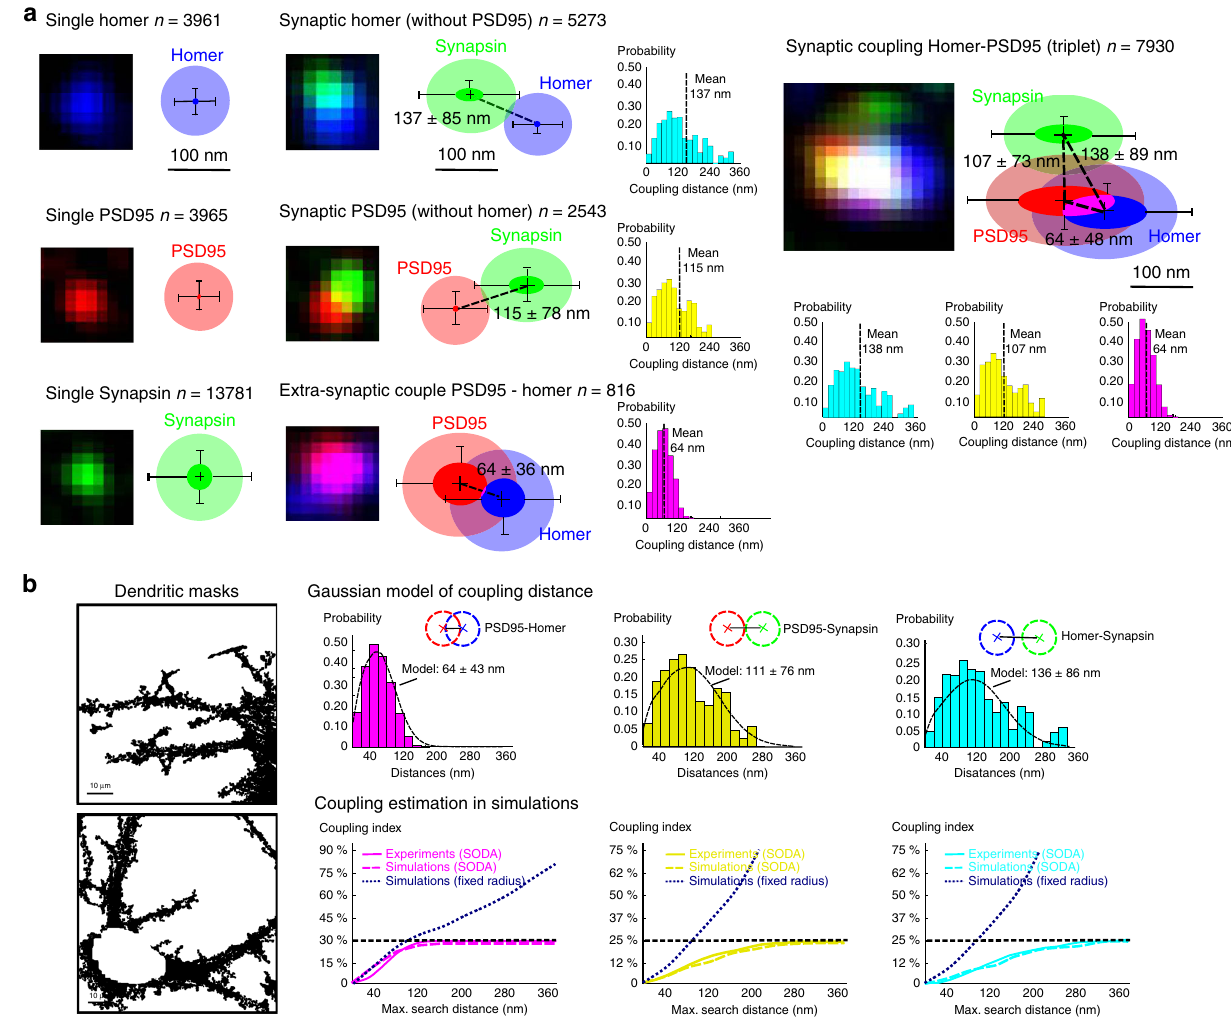
Fig. 4 A statistical view on glutamatergic synapse morphometry. a Using SODA protocol, the coupling of n = 11200 PSD95, n = 13359 Homer and n = 26505 Synapsin spots among N = 9 neurons is mapped automatically. Single Homer ( n = 3961), PSD95 ( n = 3965) and Synapsin spots ( n = 13,781) are extracted statistically. The average elliptic fi t of spots is represented at scale (error bars = ± s.d.). The transparent part represents the PSF halo. For each molecular assembly, a representative fl uorescent patch is shown. We also extract extrasynaptic couples of Homer-PSD95 ( n = 816, coupling p -value = 10 − 10 , mean cluster size = 0.025 – 0.028 µ m 2 , s.e.m. = 5.3×10 − 5 ), and synaptic appositions of PSD95 ( n = 2543, coupling p -value = 10 − 40 ) and Homer spots ( n = 5273, p -value = 10 − 21 ) (Cluster size of synaptic PSD95/Homer = 0.012 – 0.018 µ m 2 , s.e.m = 3.5×10 − 5 ). For these three couples, we represent at scale the average morphology of molecular assemblies (error bars = ± s.d.), and the weighted histograms of coupling distances. Most synaptic assemblies ( n = 7930) are composed by PSD95 and Homer apposed to Synapsin, forming a molecular triplet. In triplets, the size of dendritic clusters is even bigger (PSD95 mean size = 0.043 µ m 2 and Homer mean size = 0.038 µ m 2 ). Synapsin cluster size is smaller (mean ± s.d. = 0.018 – 0.021 µ m 2 , s.e.m. = 9.3×10 − 6 ) and similar to to the size of isolated Synapsin clusters and those solely apposed to either PSD95 or Homer. We represent the average morphology and spatial organization of ménage à trois assemblies (error bars = ± s.d.) and we plot the weighted histograms of coupling distances. Scale bar = 100 nm. b Validating the robustness of SODA with simulations. (i) Simulations inside the extracted dendritic masks are performed. Number of points (1500 PSD95 and Homer positions and 3000 Synapsin positions per dendritic mask) are similar to the observed objects (spots) ’ density. (ii) Coupling distances between PSD95, Homer and Synapsin spots are modelled with a Gaussian point process (Material and Methods). Simulated distances and coupling indexes (Homer-PSD95 = 35.4%, PSD95-Synapsin = 30.3% and Homer-Synapsin = 26.9%) are those measured experimentally with SODA. (iii) For increased searching distance, the SODA coupling index (dashed line) is compared with the measured index (solid line) and the index obtained by counting all the pairs of localisations within the search distance (dotted navy blue